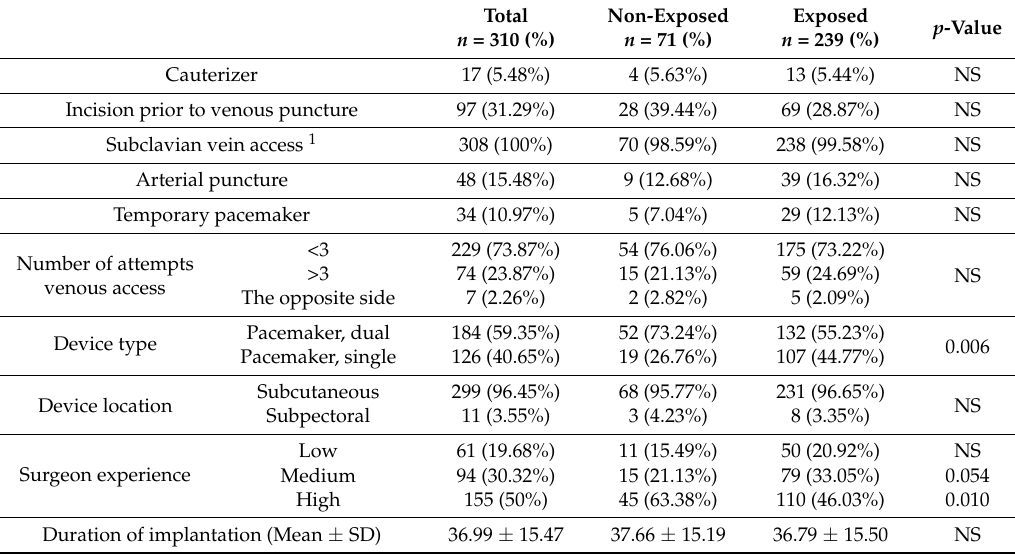
Table 3. Implant-related